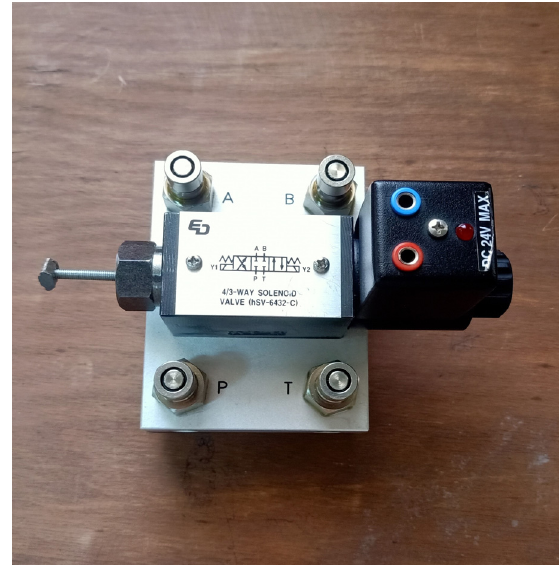
Figure 8 Modifications applied to the solenoid valve to be able to connect the LVDT.